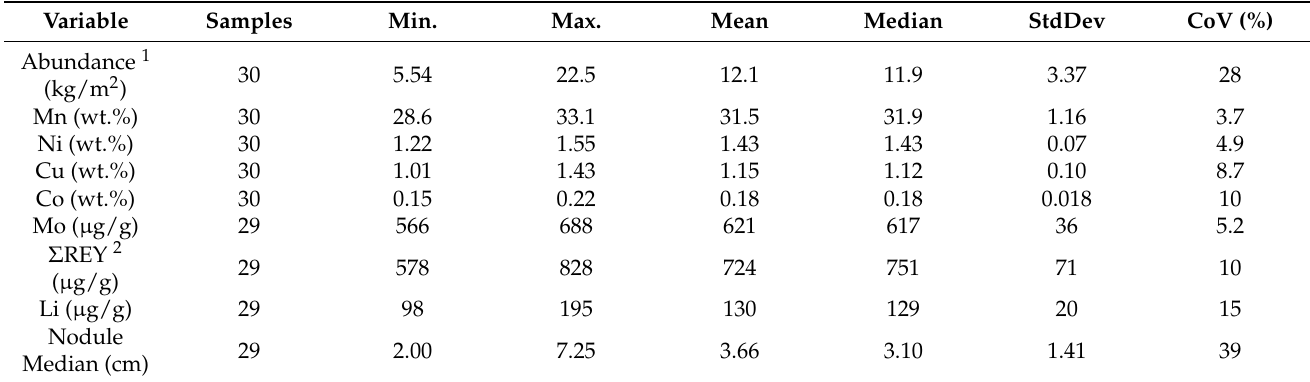
Table 8. Statistics of box core data from PA1-East.